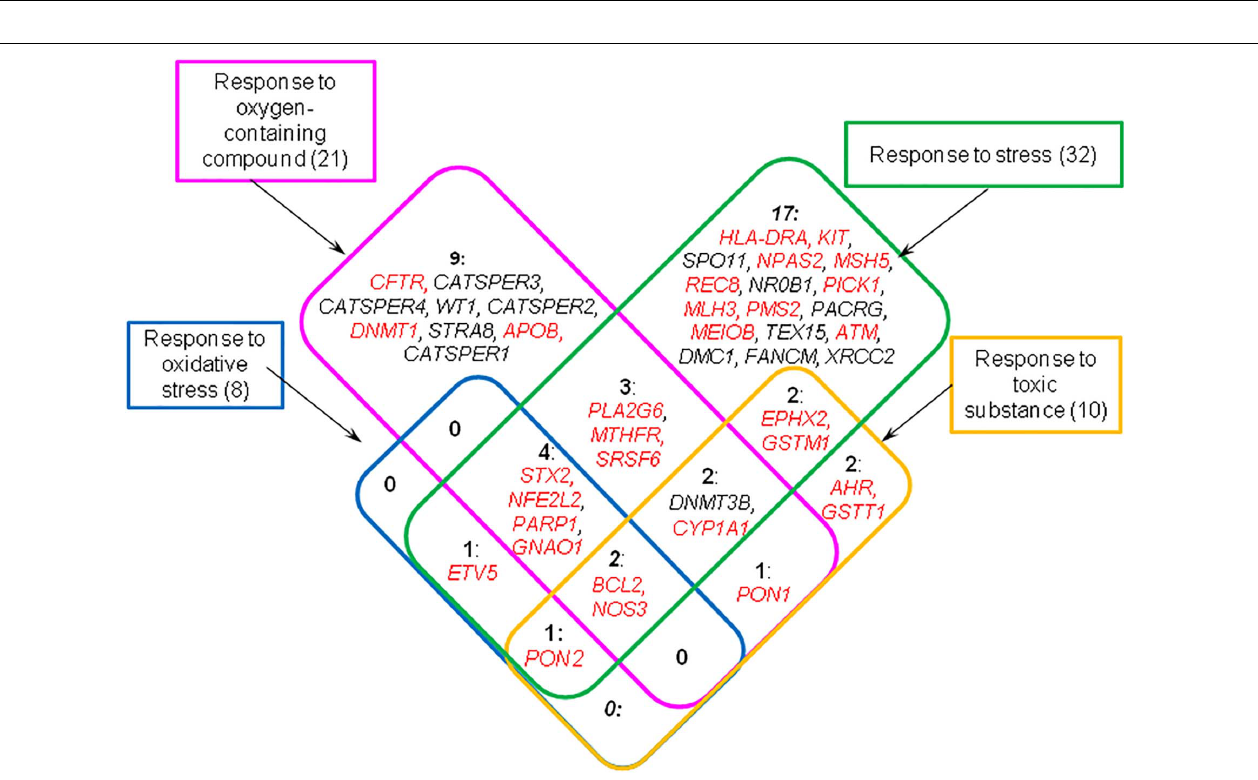
FIGURE 3 | Genes from the catalog HGAPat associated with GO terms designating response to unfavorable conditions (these terms are presented in rectangular boxes). The numbers indicate the number of genes in each group. Genes that are expressed in testis-enriched or testis-specific manner are shown in black; the other genes are shown in